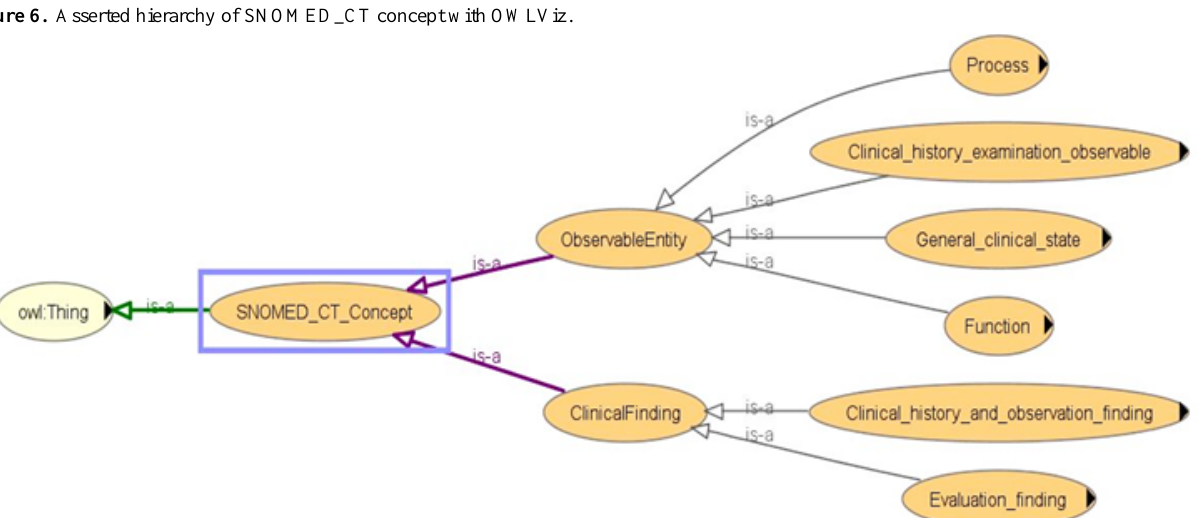
Figure 6. Asserted hierarchy of SNOMED_CT concept with